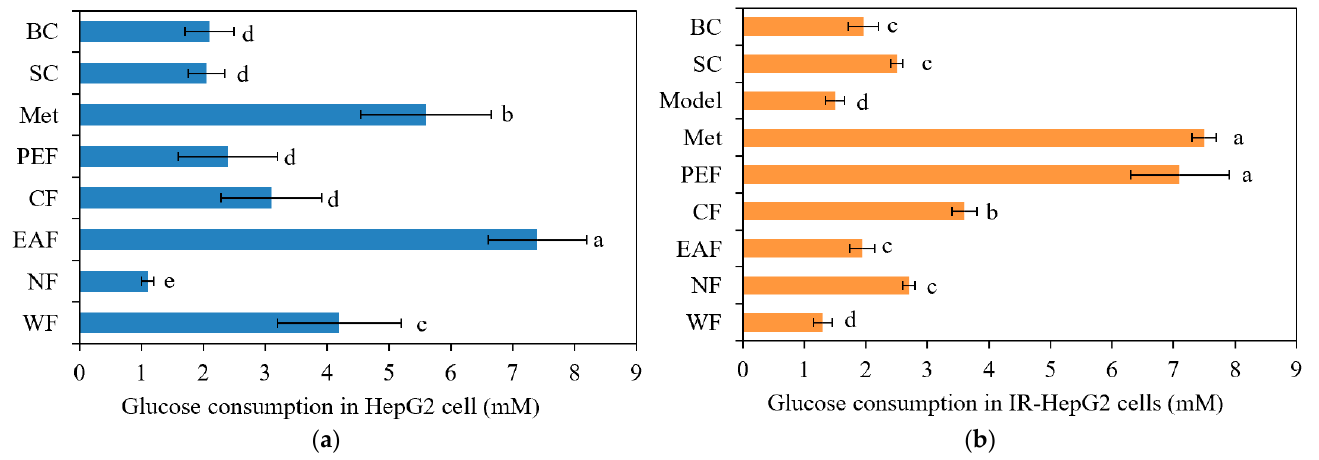
Figure 3. Effect of different extracted fractions from Pingguoli pear fermentation broth on glucose consumption in HepG2 cells ( a ) and IR-HepG2 cells ( b ). BC represents blank control, cells treated with medium; SC represents solvent control, cells treated with medium contain 0.5% ethanol. Values are mean ± SD ( n = 6). Columns with different lowercase letters are significantly different ( p < 0.05).